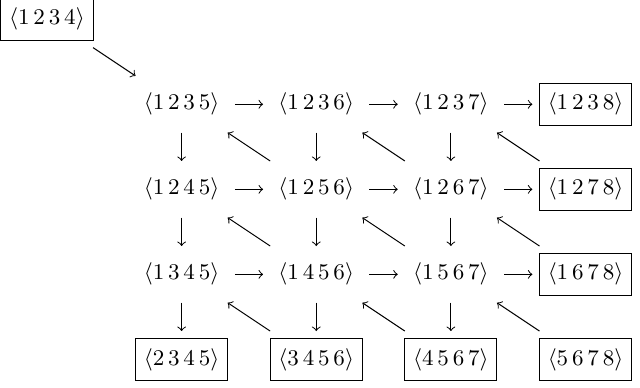
Figure 1 . The initial cluster of the Grassmannian cluster algebra Gr(4 , 8)